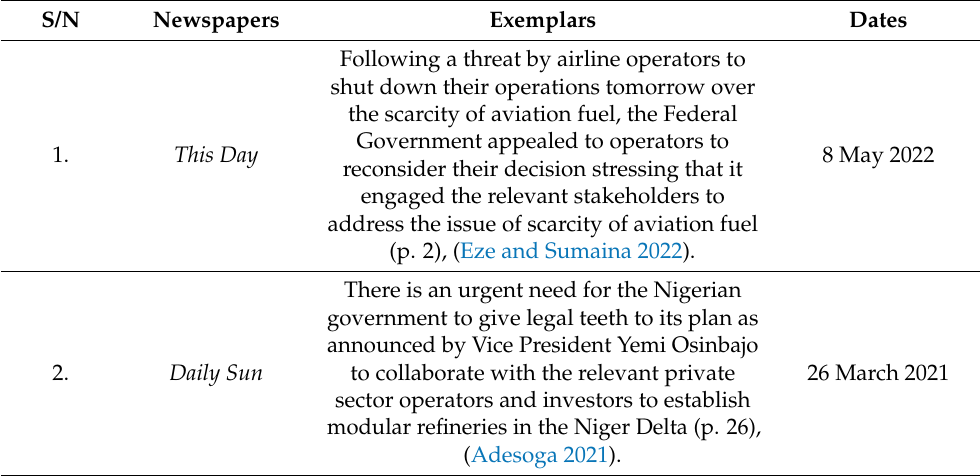
Table 2. Exemplifying Restricted Variant and the Art of Saying